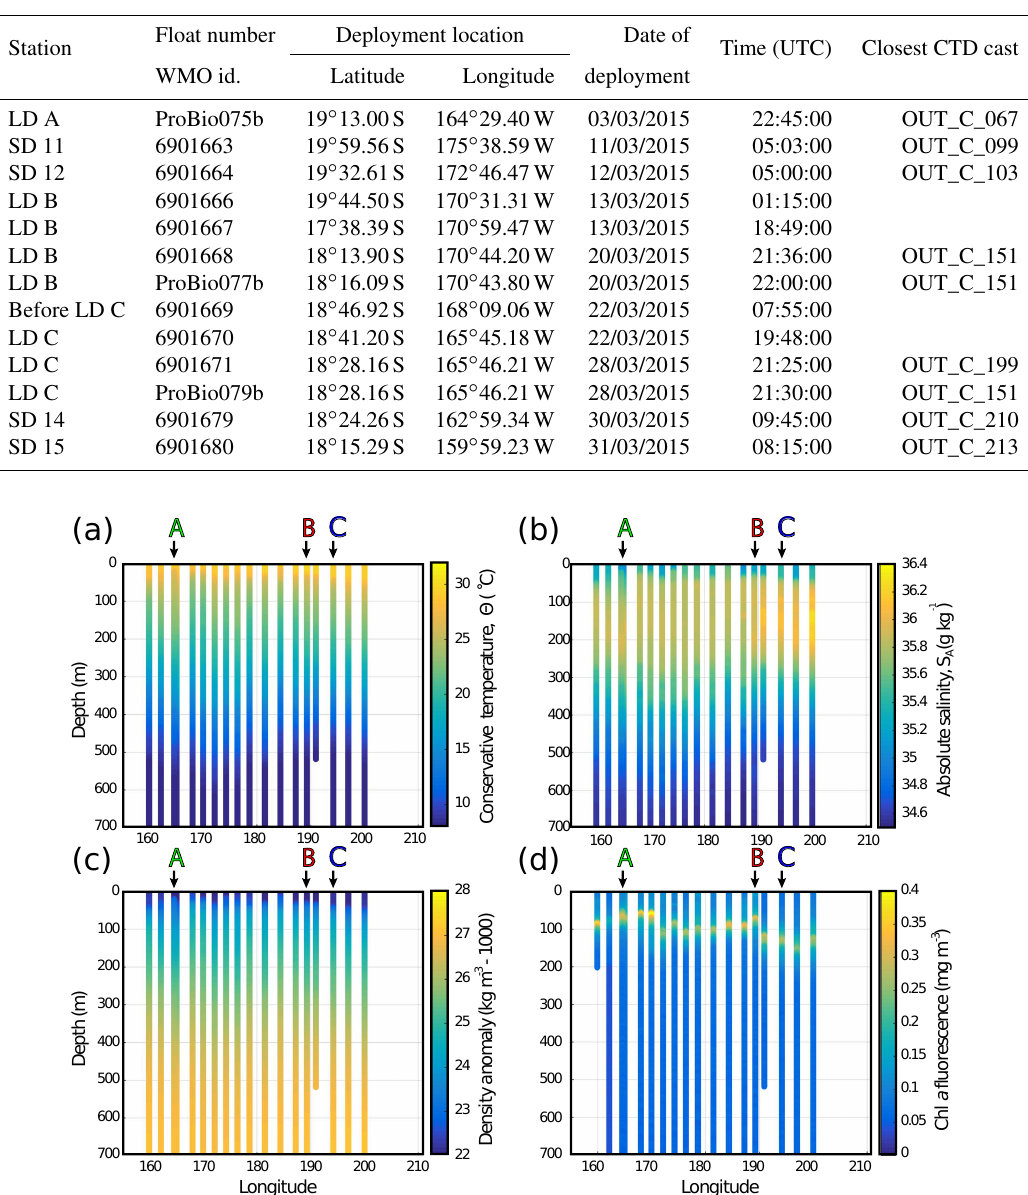
Figure 3. Zonal sections of (a) conservative temperature (cid:50) , (b) absolute salinity SA, (c) density anomaly, and (d) fluorescence in the upper 700 m from the classic CTD rosette at SD and LD stations along the OUTPACE transect. The three LD stations are highlighted by their color-coded letter and corresponding